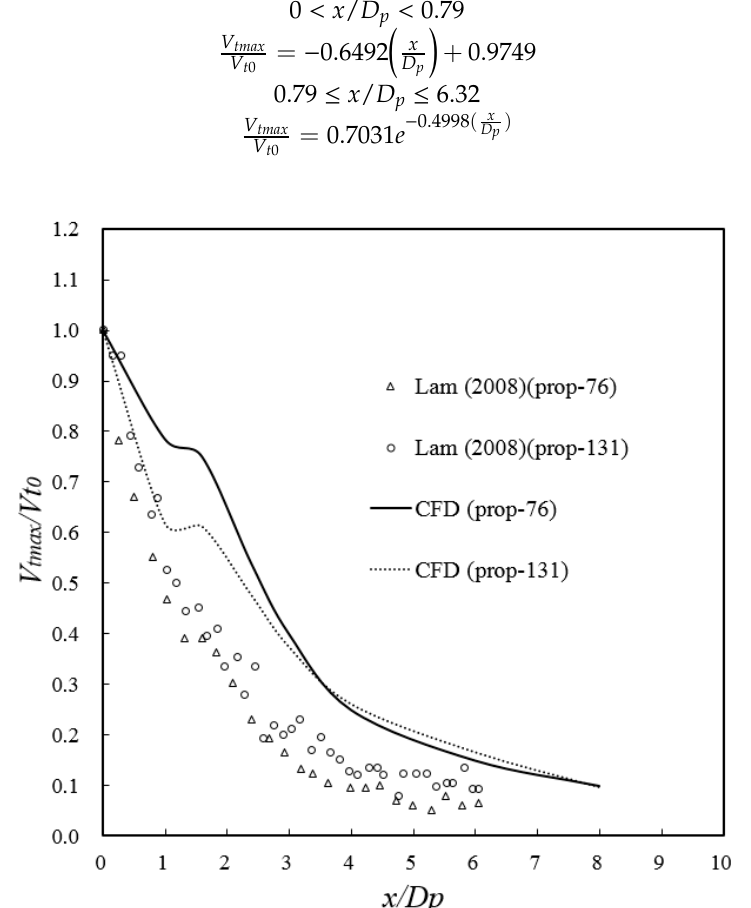
Figure 12. Tangential velocity decay.